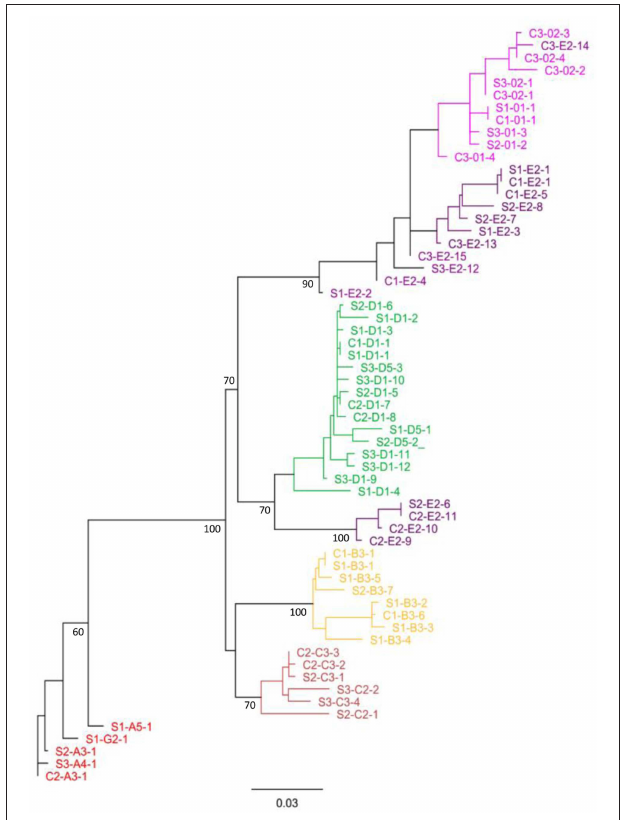
FIGURE 8 | Single cell SpTrf gene sequences cluster according to element patterns. The phylogenetic relationships of SpTrf amplicon sequences containing most of the second exon were inferred using maximum parsimony, neighbor joining (results not shown), and maximum likelihood, all of which gave similar results. The tree shown here is based on the maximum likelihood phylogeny with PhyML according to Jukes-Cantor model with 1,000 bootstrap replicates. Bootstrap values for nodes present in > 50% of trees are shown. Sequences from sperm (S) or coelomocyte (C) are indicated accordingly and accompanied with animal number (1, 2, or 3). The letter and number after the first dash indicate the element pattern based on previously published nomenclature (7, 8, 16). The last number after the second dash indicates the sequence sub-categories based on SNP variations within an element pattern. Colors indicate the gene element pattern according to Miller et al. ( 7) and Buckley and Smith